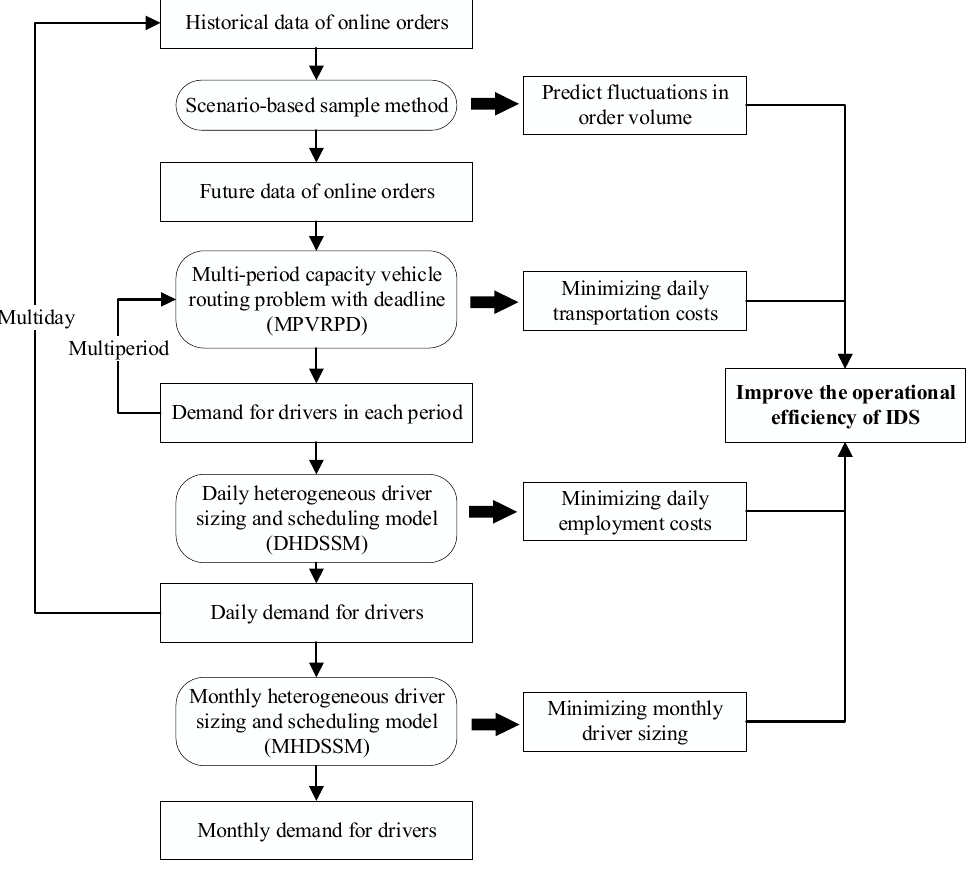
Fig. 1. Framework of the three-stage optimization